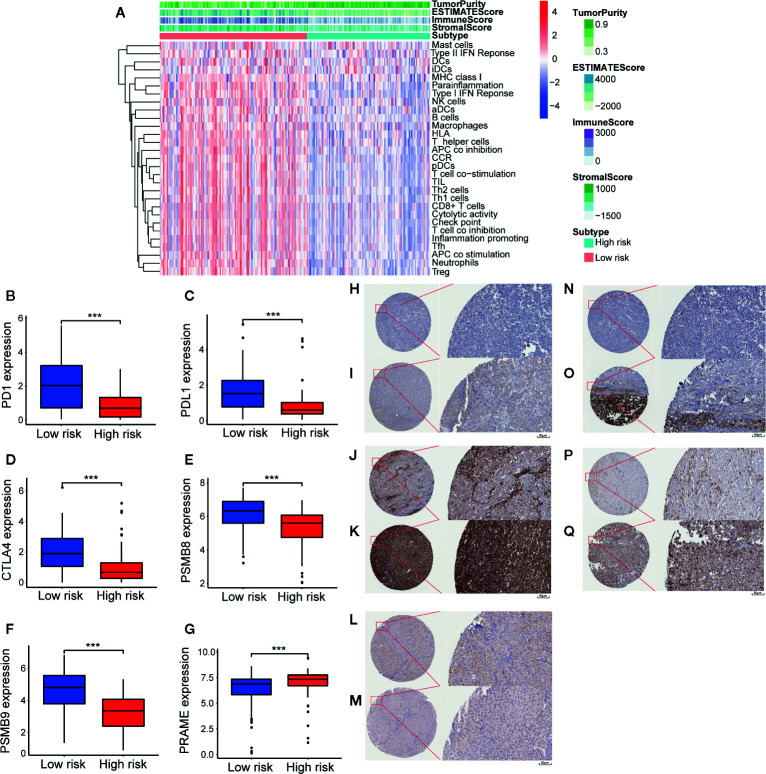
Tumor micro-environment (TME) and key genes expression in two different groups. In TME, “TumorPurity” is the percentage of tumor cells, “ImmuneScore” is the percentage of Immune cells, “StromalScore” is the percentage of stromal cells, “EstimateScore” is the percentage that merge the “ImmuneScore” and “StromalScore”. as we can see, high risk group had higher tumor purity with lower immune cells and stromal cells infiltration (A). In low immune risk group, PD-1, PD-L1, CTLA-4, PSMB8, and PSMB9 were highly expressed (B–F). PRAME were significant expressed in high risk group (G). (H) IHC result of PD-1 protein in high risk group. Staining, not detected; intensity, negative; quantity, none; location, none. (I) IHC result of PD-1 protein in low risk group. Staining, low; intensity, weak; quantity, 75%–25%; location, cytoplasmic/membranous. (J) IHC result of PD-L1 protein in high risk group. Staining, not detected; intensity, negative; quantity, none; location, none. (K) IHC result of PD-L1 protein in low risk group. Staining, high; intensity, Strong; quantity, >75%; location, cytoplasmic/membranous. (L) IHC result of PSMB8 protein in high risk group. Staining, low; intensity, moderate; quantity, <25%; location, cytoplasmic/membranous nuclear. (M) IHC result of PSMB8 protein in low risk group. Staining, high; intensity, Strong; quantity, >75%; location, cytoplasmic/membranous nuclear. (N) IHC result of PSMB9 protein in high risk group. Staining, not detected; intensity, negative; quantity, none; location, none. (O) IHC result of PSMB9 protein in low risk group. Staining, medium; intensity, moderate; quantity, >75%; location, cytoplasmic/membranous nuclear. (P) IHC result of PRAME protein in high risk group. Staining, medium; intensity, moderate; quantity, 75%–25%; location, cytoplasmic/membranous. (Q) IHC result of PRAME protein in low risk group. Staining, not detected; intensity, weak; quantity, <25%; location, cytoplasmic/membranous. ***p < 0.01 (t-test).